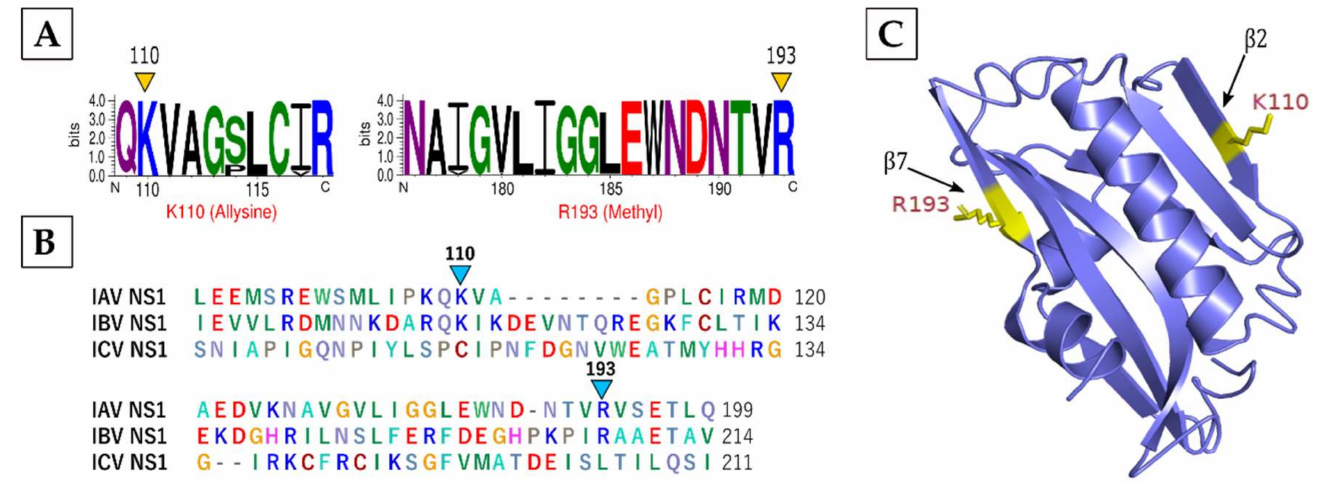
Figure 4. The characteristics of the modifications on IAV NS1. ( A ) Conservation of modified residues across NS1 of IAV subtypes. A total of 998 sequences from 48 different IAV subtype strains were aligned in BioEdit using ClustalW and visualized by WebLogo. The logos represent individual peptides with modified residues (yellow arrowheads). The X -axis indicates the position of amino acid and the Y -axis indicates the bit score on a scale of 1–4 (A scale of 4 means 100% conservation). Methyl: methylation. ( B ) Conservation of modified residues across NS1 of IAV, IBV, and ICV. Turquoise arrowheads point to conservation in IAV and IBV. ( C ) Location of modified residues in the NS1 effector domain structure. Yellow atom stick indicates the location on β